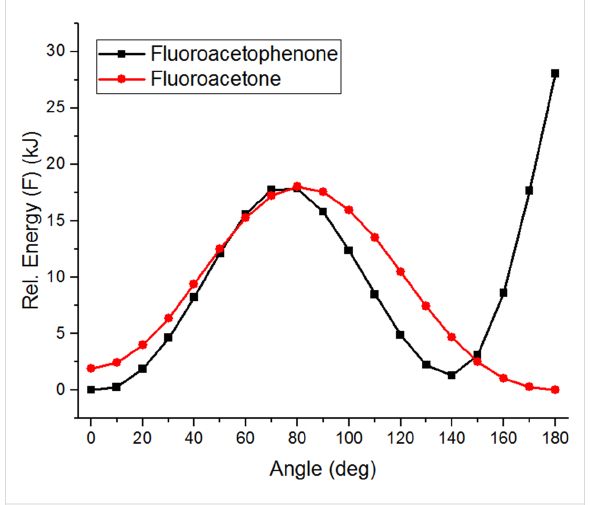
Figure 9: Overlay of conformational energy profiles of fluoroacetone and